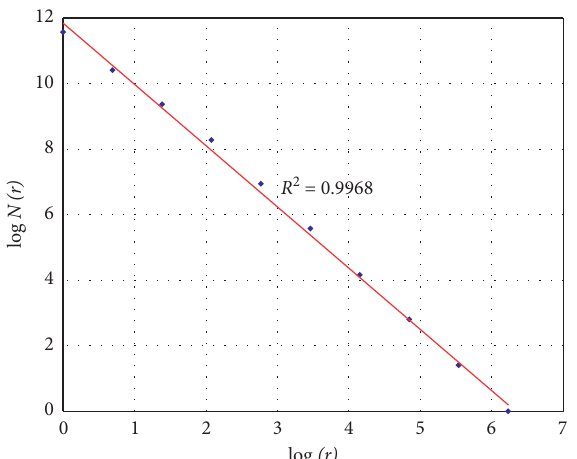
Figure 15: Fractal characteristics of the failure area when the stress level is 100% and the confining pressure is 10